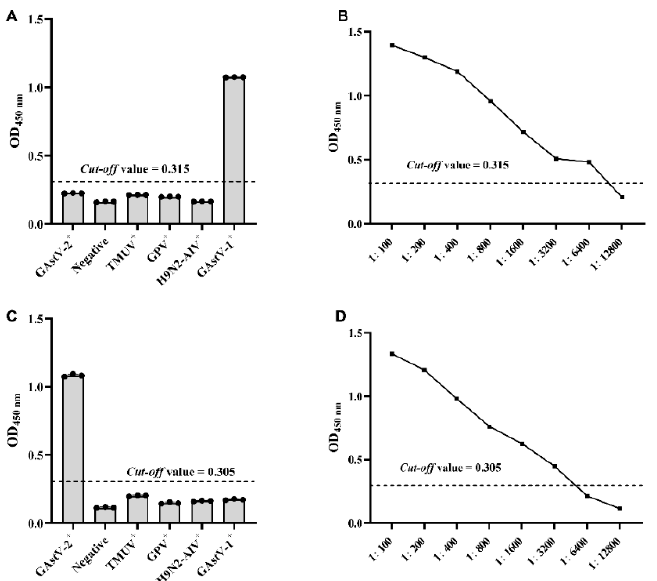
Figure 5. Specificity and sensitivity of GAstV-1-ELISA and GAstV-2-Cap-ELISA. ( A ) The specificity of GAstV-1-ELISA. The OD 450 nm was determined using positive serum samples against GAstV-1, GAstV-2, TMUV, GPV, and H9N2-AIV and negative serum. ( B ) The sensitivity of GAstV-1-ELISA. The positive sera were diluted to 1:100, 1:200, 1:400, 1:800, 1:1600, 1:3200, 1:6400, and 1:12,800. ( C ) The specificity of GAstV-2-Cap-ELISA. The OD 450 nm was determined using positive serum samples against GAstV-1, GAstV-2, TMUV, GPV, and H9N2-AIV and negative serum. ( D ) The sensitivity of GAstV-2-Cap-ELISA. The positive sera were diluted to 1:100, 1:200, 1:400, 1:800, 1:1600, 1:3200, 1:6400, and 1:12,800. Table 2. Intra- and inter-plate repeatability test of GAstv-1-ELISA and GAstV-2-Cap-ELISA. Serum Samples